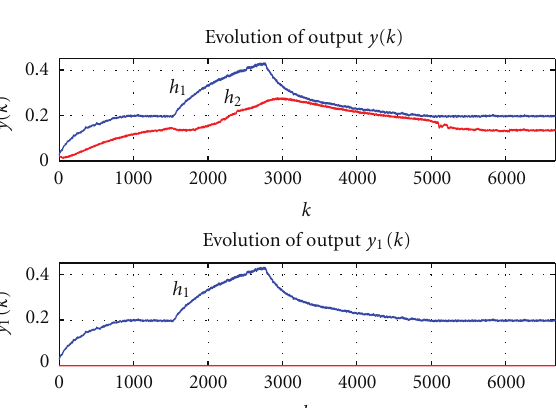
Figure 5: IC-residual v ( k ).